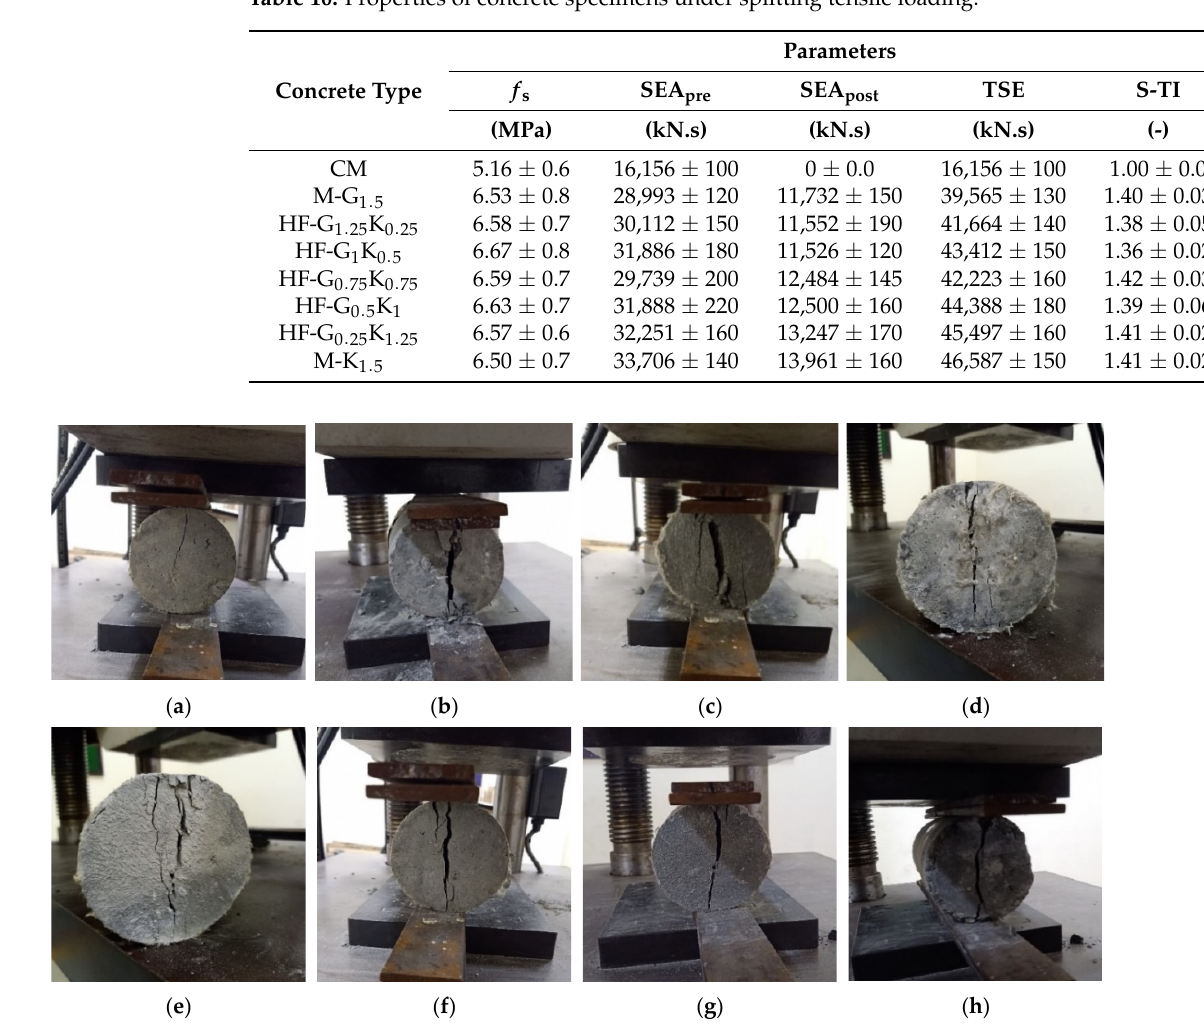
Figure 10. Splitting tensile failure modes of specimens: ( a ) CM; ( b ) M-G 1.5 ; ( c ) HF-G 1.25 K 0.25 ; ( d ) HF-G 1 K 0.5 ; ( e ) HF-G 0.75 K 0.75 ; ( f ) HF-G 0.5 K 1 ; ( g ) HF-G 0.25 K 1.25 ; ( h ) M-K 1.5 .